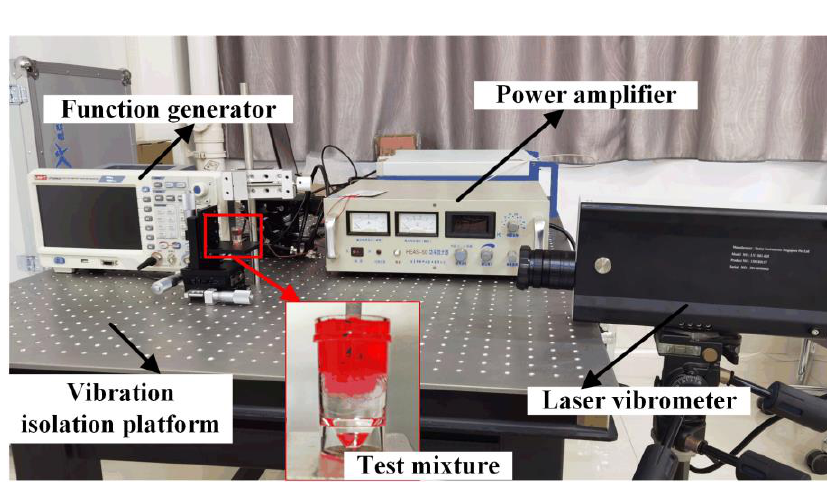
Figure 18. Full flow of fluid in a blood vessel.